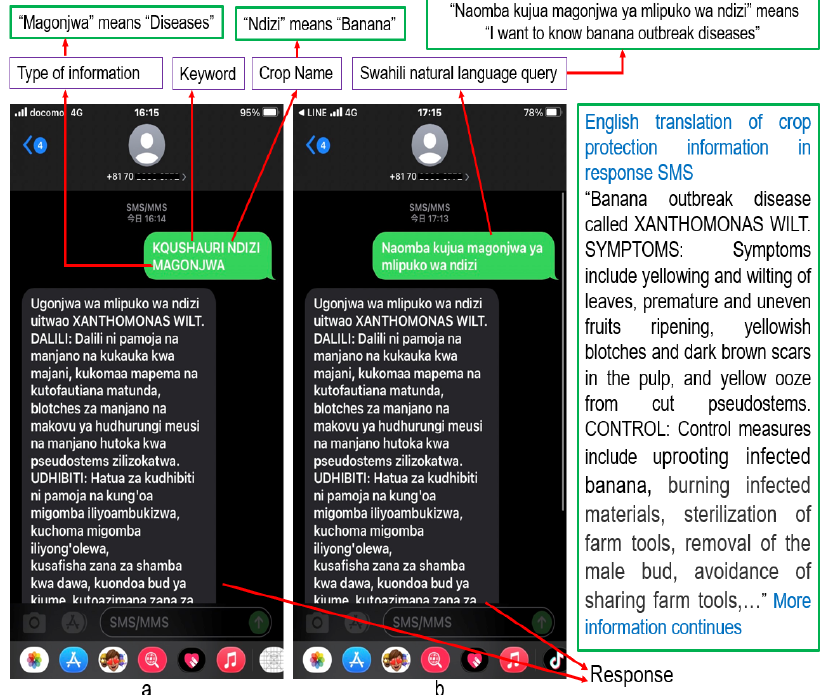
Figure 6. Farmer requesting and receiving banana crop protection information (symptoms and control measures of banana Xanthomonas wilt) through SMS: ( a ) Keyword SMS query. ( b ) Natural language SMS